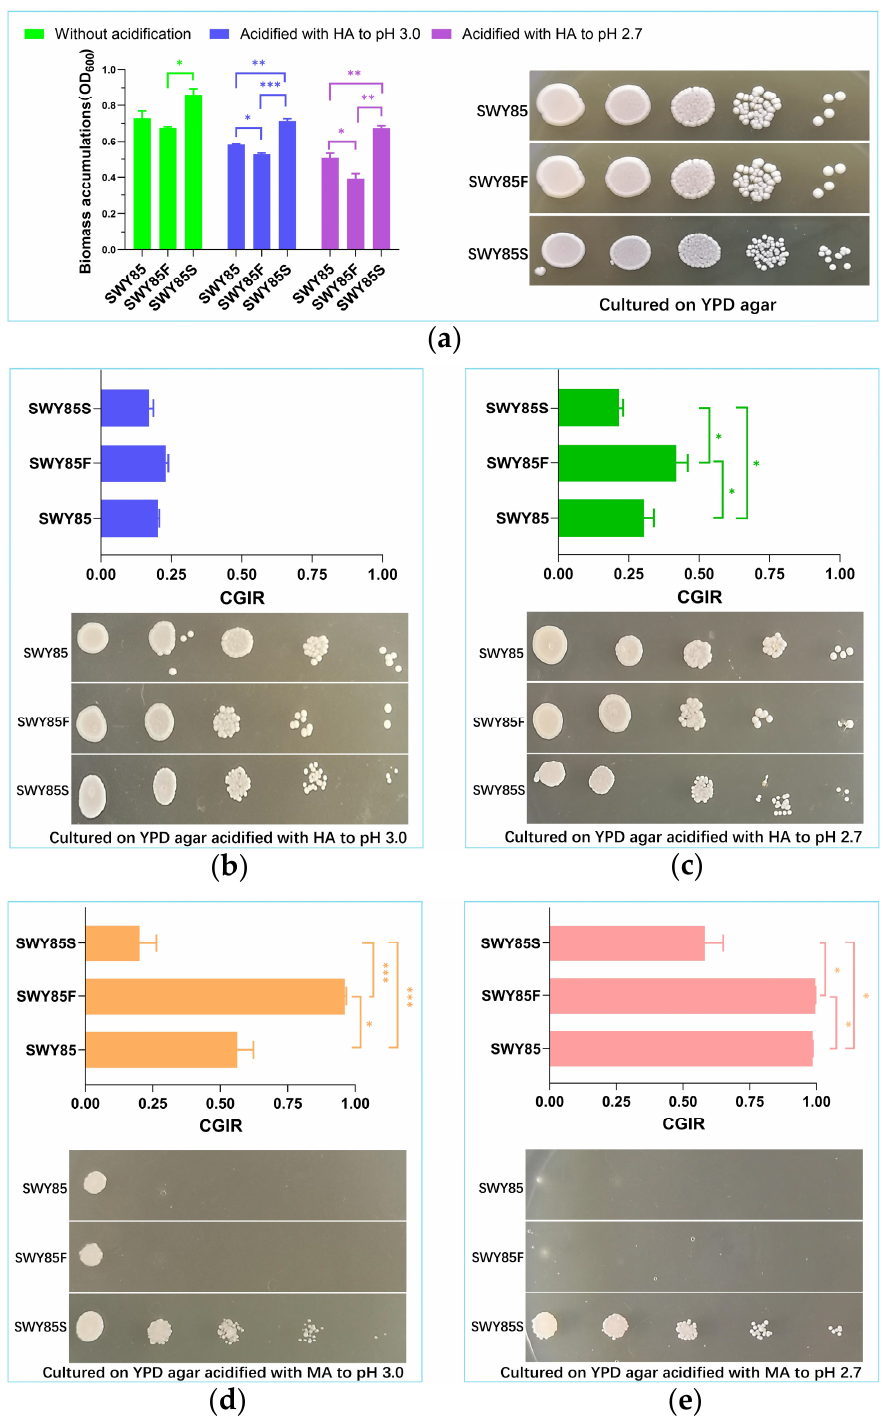
Figure 1. The effect of malic acid stress on cellular growth of the three strains. The colonies formed on YPD agar and the biomass accumulation of the three strains cultivated in YPD medium with and without acid acidification ( a ). The colonies formed on acidified YPD agar and the cell growth inhibitory rates (CGIR) of the three strains cultured with an adequate nutrient supply under hydrochloric acid acidification to pH 3.0 ( b ) and pH 2.7 ( c ), respectively, and with malic acid stress acidified to pH 3.0 ( d ) and pH 2.7 ( e ), respectively. HA, Hydrochloric acid; MA, Malic acid. * p < 0.05, ** p < 0.01, *** p < 0.001.